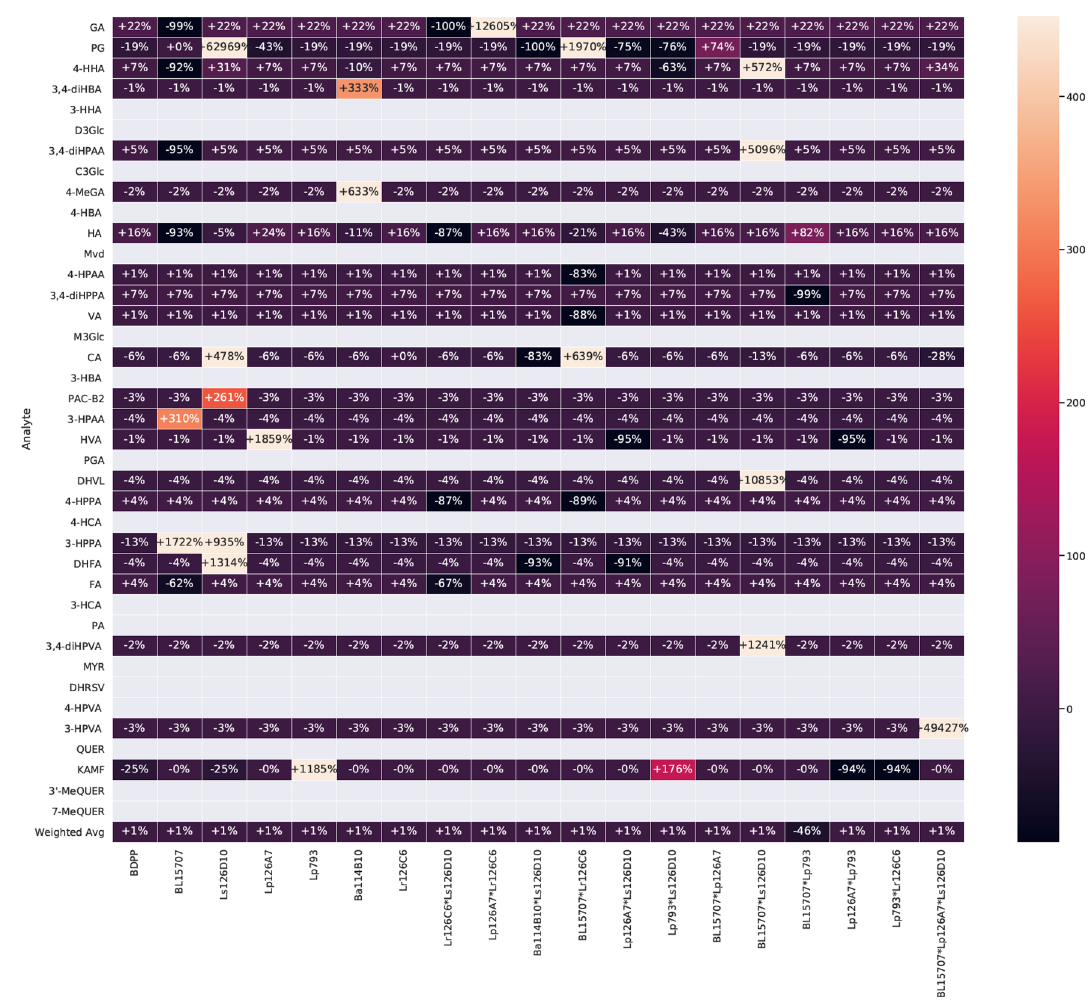
Figure 6. Predicted synergisms in metabolite production between probiotics using the MARS algorithm. Metabolite production from the polyphenolic precursor BDPP after exposure to 5 days of 12 probiotic combinations was calculated with a UPLC-QqQ/MS. Each row represents an individual metabolite, while each column represents a unique probiotic or combination of probiotics. For each metabolite, the model coefficients are represented as percentages. Rows masked in grey indicate metabolites for which production was not affected by the presence of probiotics. Gallic acid (GA), pyrogallol (PG), 4-hydroxyhippuric acid (4-HHA), 3,4-dihydroxybenzoic acid (3,4-HBA), 3-hydroxyhippuric acid (3-HHA), Delphinidin-3-O- glucoside (D3Glc), 3-(3,4-dihydroxyphenyl)propionic acid (3,4-diHPPA), cyanidin-3-glucoside (C3Glc), 4-O-methylgallic acid (4-MeGA), 4-hydroxybenzoic acid (4-HBA), hippuric acid (HA), malvidin (Mvd), 4-hydroxyphenylacetic acid (4-HPAA), 3,4-dihydroxyphenylacetic acid (3,4-diHPAA), vanillic acid (VA), malvidin-3-glucoside (M3Glc), caffeic acid (CA), 3-hydroxybenzoic acid (3-HBA), proanthocyanidin dimer B2 (PAC-B2), 3-hydroxyphenylacetic acid (3-HPAA), homovanillic acid (HVA), phloroglucinaldehyde (PGA), 5-(3 ′ ,4 ′ -dihydroxyphenyl)-γ-valerolactone (DHVL), 3-(4-hydroxyphenyl)propionic acid (4-HPPA), 4-hydroxycinnamic acid (4-HCA), 3-(3-hydroxyphenyl)propionic acid (3-HPPA), dihydroferulic acid (DHFA), ferulic acid (FA), 3-hydroxycinnamic acid (3-HCA), phenylacetic acid (PA),